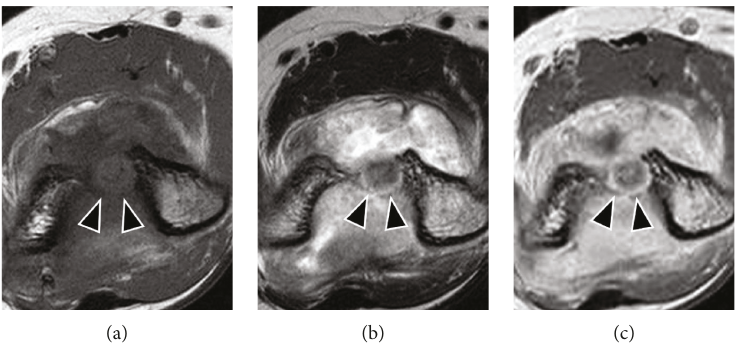
Figure 3: Axial T1-weighted (a), T2-weighted (b), and gadolinium-enhanced (c) images on preoperative magnetic resonance imaging. The round lesion shows slightly hyperintense signals compared to adjacent muscles on T1-weighted imaging and hyperintense to intermediate-intensity signals on T2-weighted sequences, with heterogeneous enhancement (arrowhead).